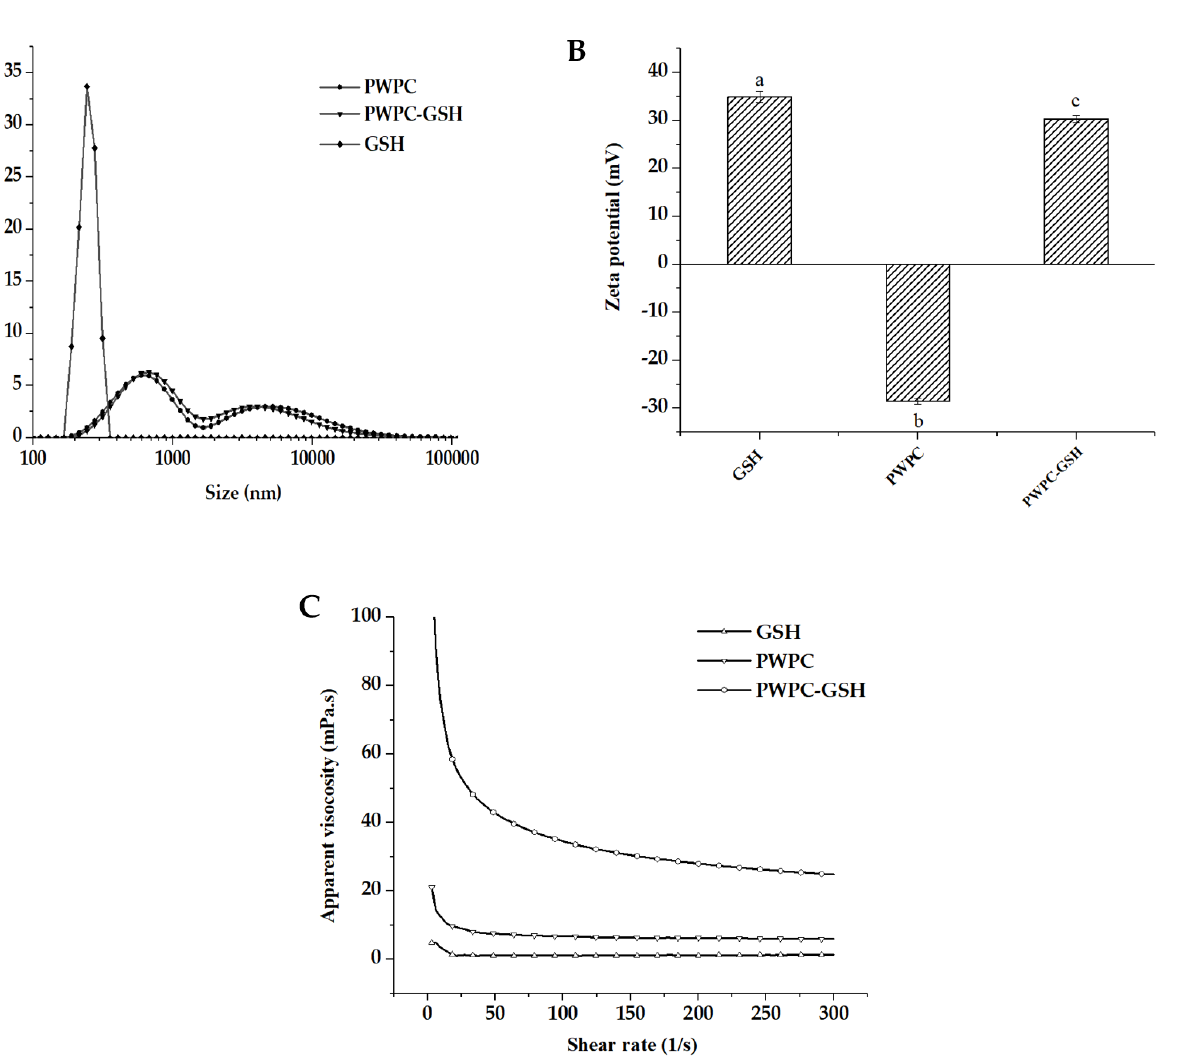
Figure 1. ( A ) Particle size distribution, ( B ) zeta potential, ( C ) apparent viscosity of glutathione (GSH), polymerized whey protein concentrate (PWPC) and polymerized whey protein concentrate encapsulated GSH (PWPC-GSH). In Figure 1B, completely different lower-case letters between samples mean significant difference ( p < 0.05).